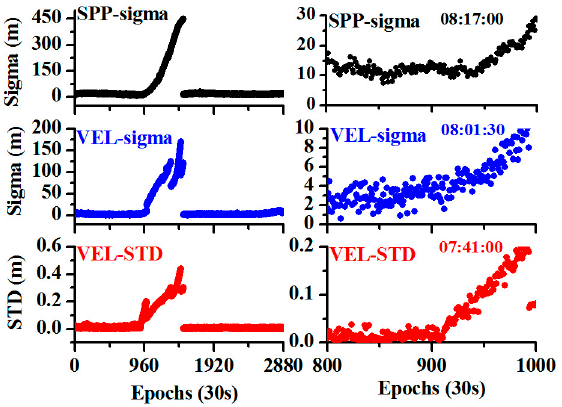
Figure 2. Comparison of different approaches for the detection of the orbital maneuver (the black color represents the mean square error (MSE) for single point positioning (SPP), the blue color represents the MSE for velocity estimation, and the red color represents the standard deviation STD for velocity estimation; the left plots denote the values of estimated parameters during one day, and the right plots denote the values of the estimated parameters during the maneuver period).